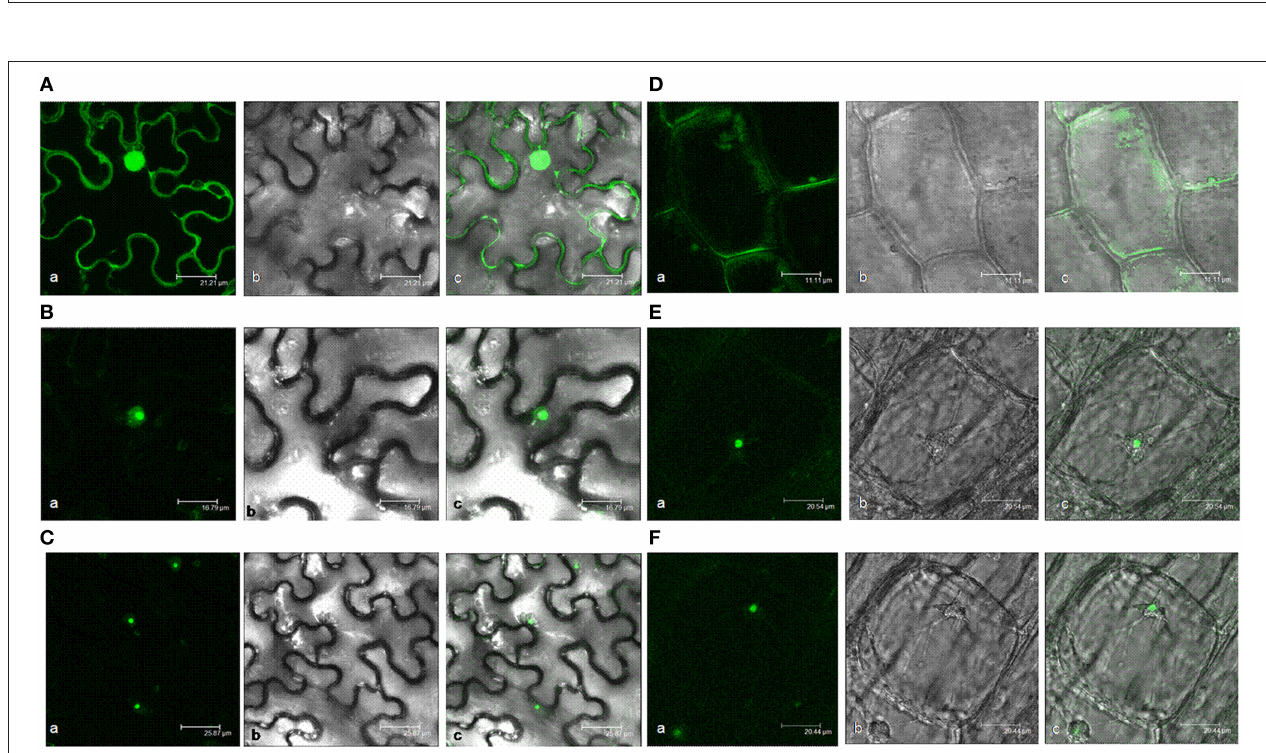
FIGURE 3 | Subcellular localization analyses of 35S:AtHD2D and 35S:AtHD2D-GFP. (a) Fluorescence image, (b) With white light, (c) Merge of fluorescence and bright images. (A) Subcellular localization of 35S:GFP in N. bentamiana . (B) Subcellular localization of AtHD2D-GFP in N. bentamiana . (C) General view of subcellular localization of AtHD2D-GFP in N. bentamiana . (D) Subcellular localization of 35S:GFP in root tip of transgenic Arabidopsis . (E) Subcellular localization of 35S:AtHD2D-GFP in root tip of transgenic Arabidopsis . (F) General view of subcellular localization of 35S:AtHD2D-GFP in root tip of transgenic Arabidopsis .